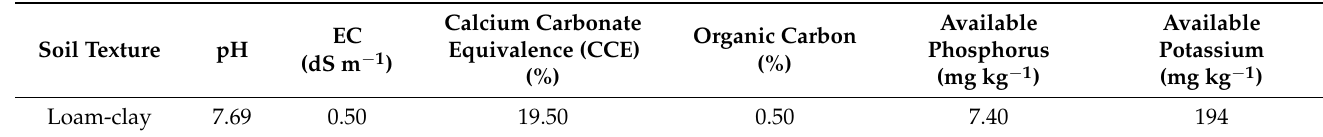
Table 1. Physical and chemical characteristics of soil used in the